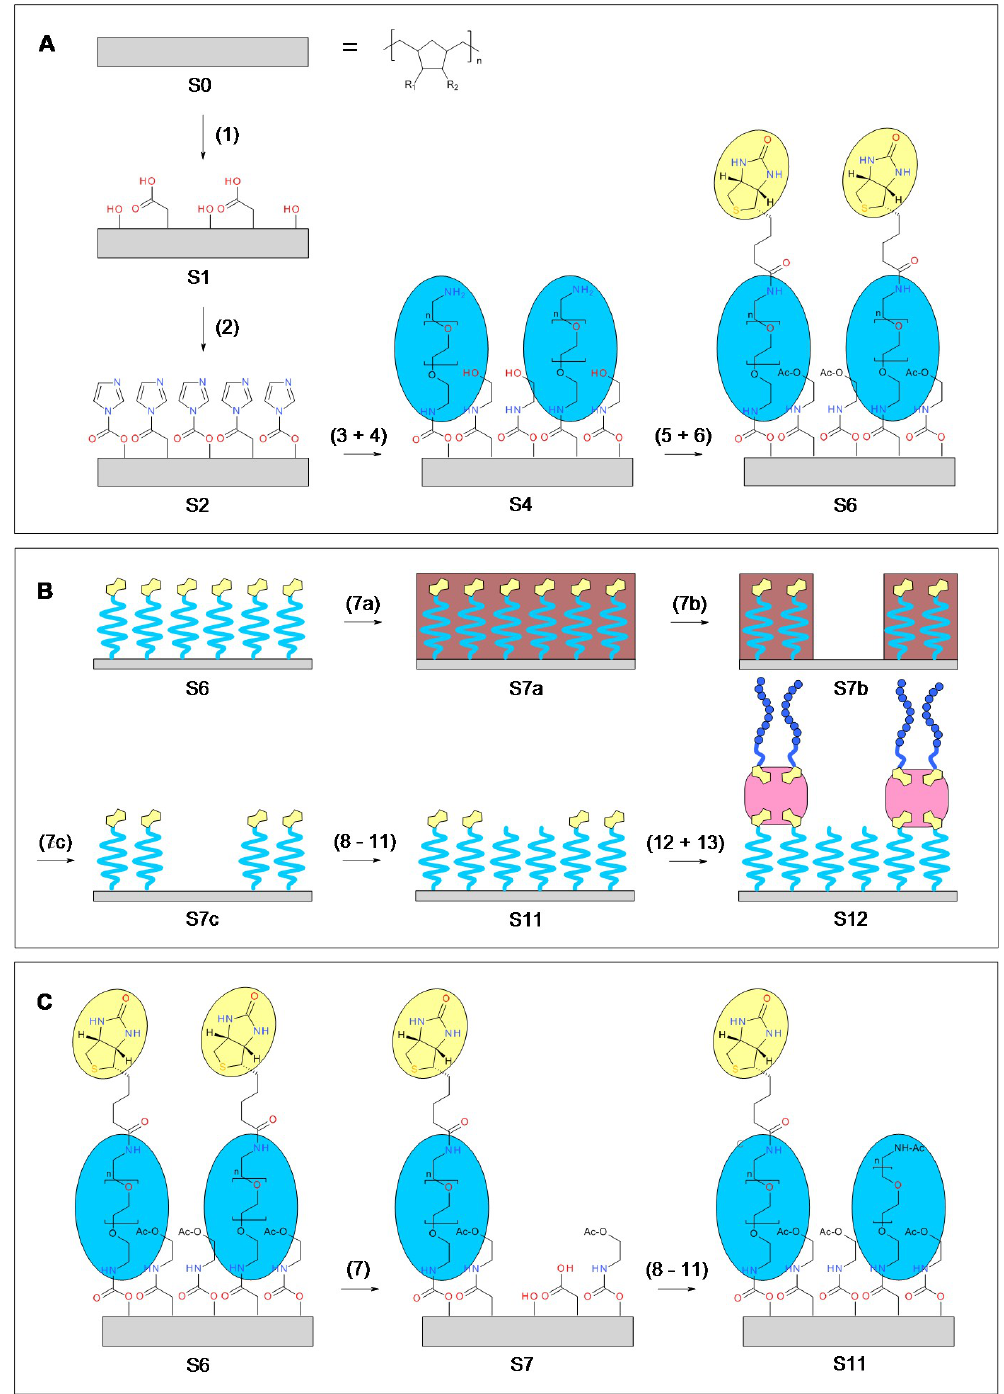
Figure A1. Schematic overview of surface chemistry and micro-patterning procedure on COP substrate. ( A ) Fabrication of PEG layer with terminal biotin groups on COP surface. ( B ) Micro-patterning process via photolithography leading to a micropatterned biotin-PEG layer. ( C ) Surface chemistry before and after micro‐patterning.